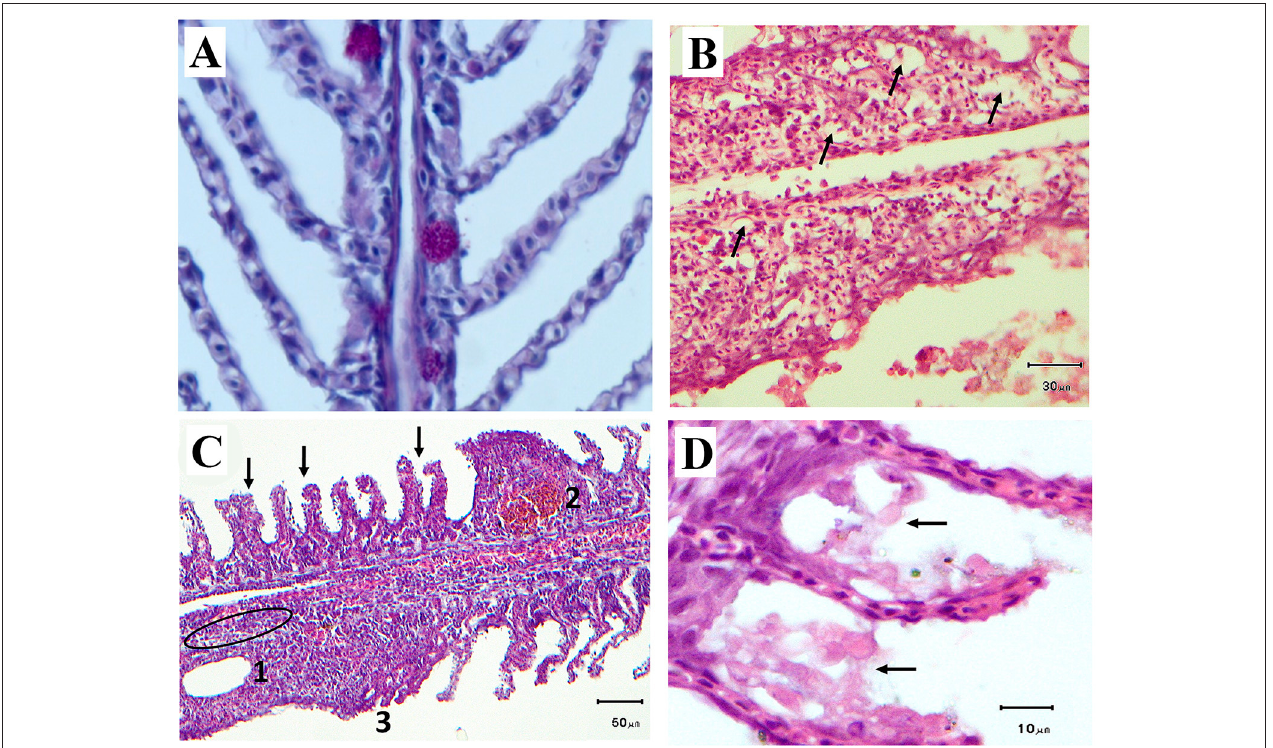
FIGURE 6 | (A) Healthy gills with undamaged primary lamellae and presence of mucous cells (400x); (B–D) . Pathological features in gills from sampled Dicentrarchus labrax at aquaculture facilities in Spain; (B) Lamellar oedema (black arrows); (C) Hyperplasia of primary lamellae (black arrows), lymphocytes accumulation (black circle), and 1, lacunae formation; 2, circulatory disturbances (telangectasia); 3, lamellar fusion; (D) cellular